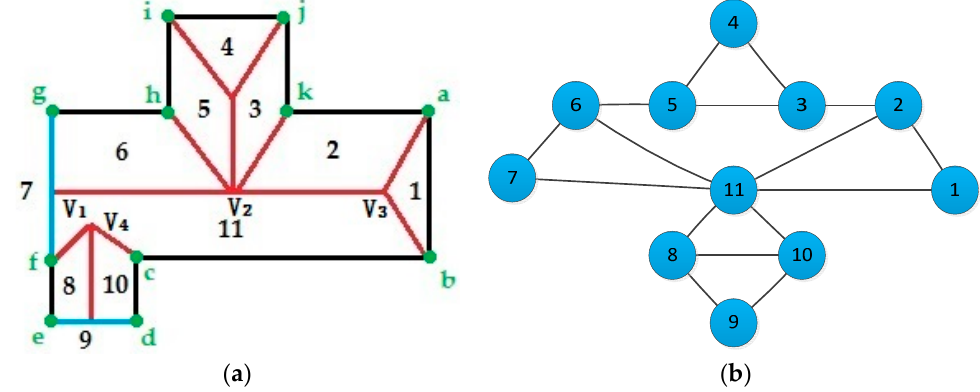
Figure 9. A complex roof and corresponding RTG: ( a ) a complex roof, green points donate the vertices on outline, blue lines denote the perpendicular planes; and ( b ) the corresponding RTG.